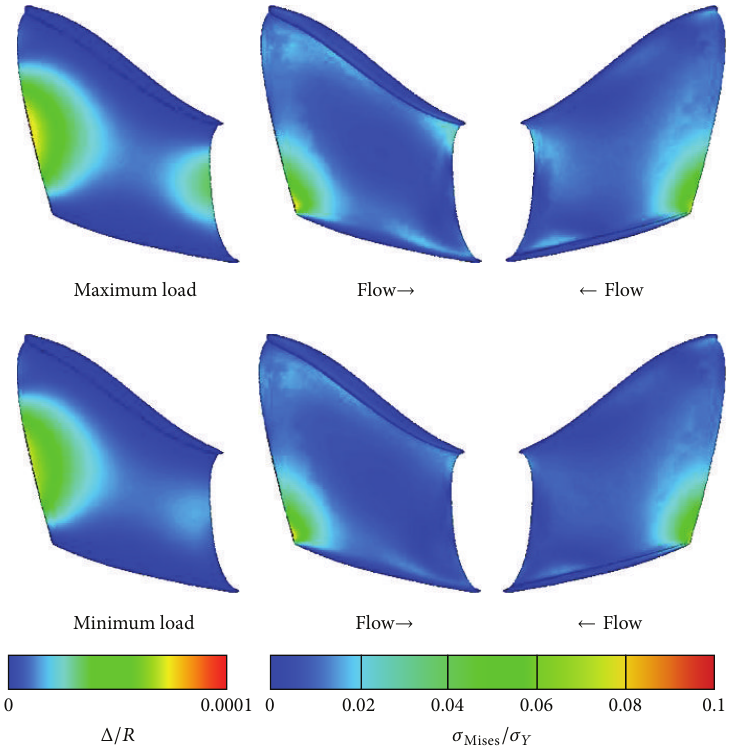
Figure 24: Normalized deformation contours (left) and von Mises stress contours (right) for blade-2 of the stator corresponding to the maximum and minimum load experienced by the blade along one revolution ( 𝑅 = 0.85 m, 𝜎 𝑌 = 450